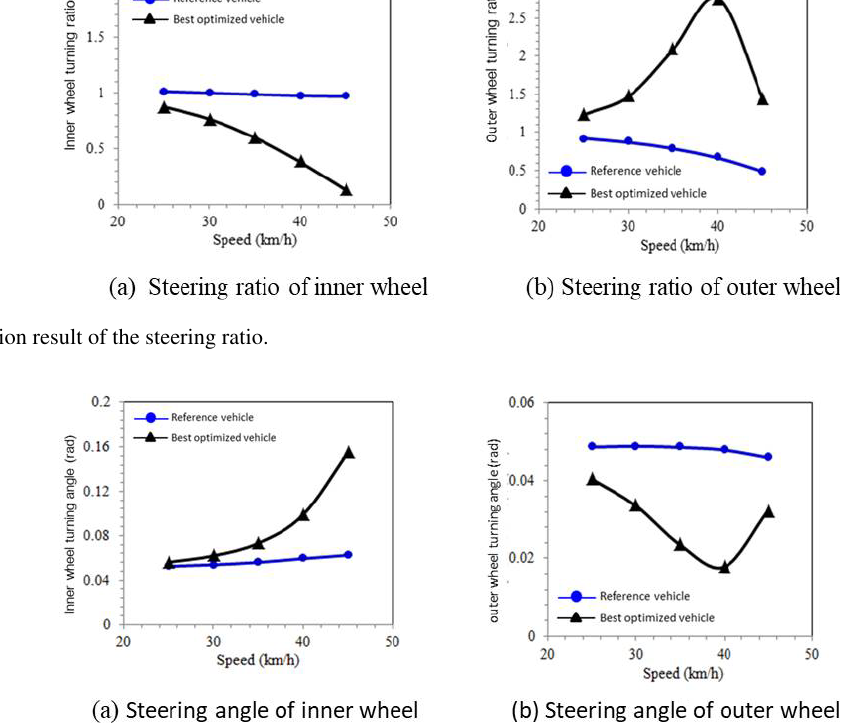
Figure 23. Simulation result of the steering angle.